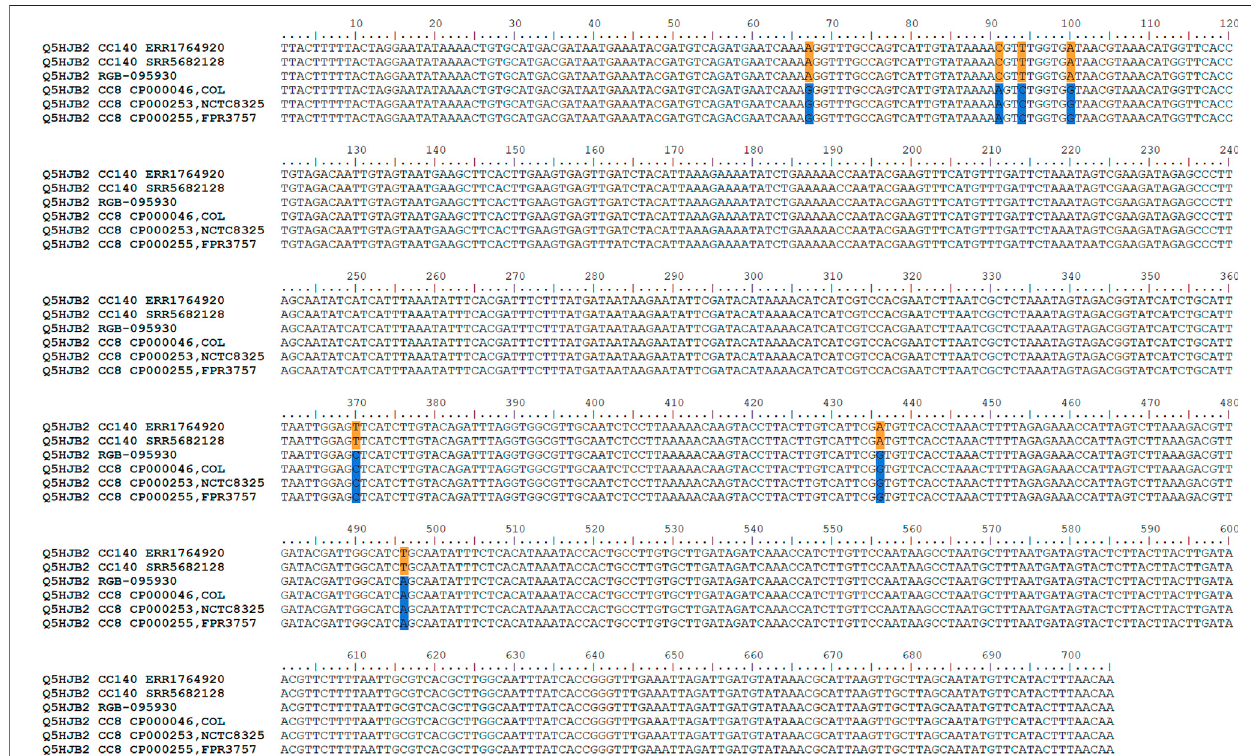
FIGURE4| AlignmentshowingQ5HJB2sequencesofRGB-095930aswellasofCC8andCC140strains.NotethatRGB-095930sharesSNPswithCC140inthe fi rst part of the sequence but with CC8 in the second. CC8-speci fi c SNPs are indicated in blue, CC140 ones in orange.